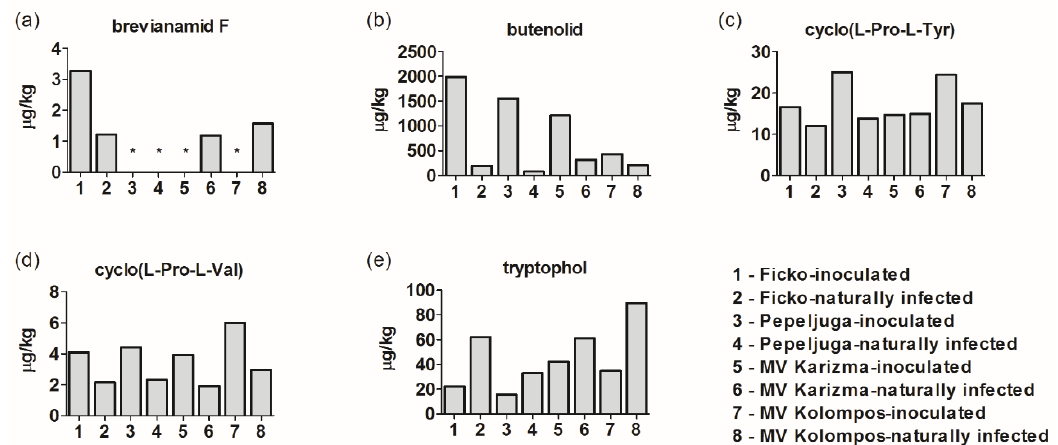
Figure 3. Other metabolites in Fusarium -inoculated and naturally-infected samples: brevianamid F ( a ), butenolid ( b ), cyclo(L-Pro-L-Tyr) ( c ), cyclo(L-Pro-L-Val) ( d ), and tryptophol ( e ). The asterisk (*) indicates < LOD.